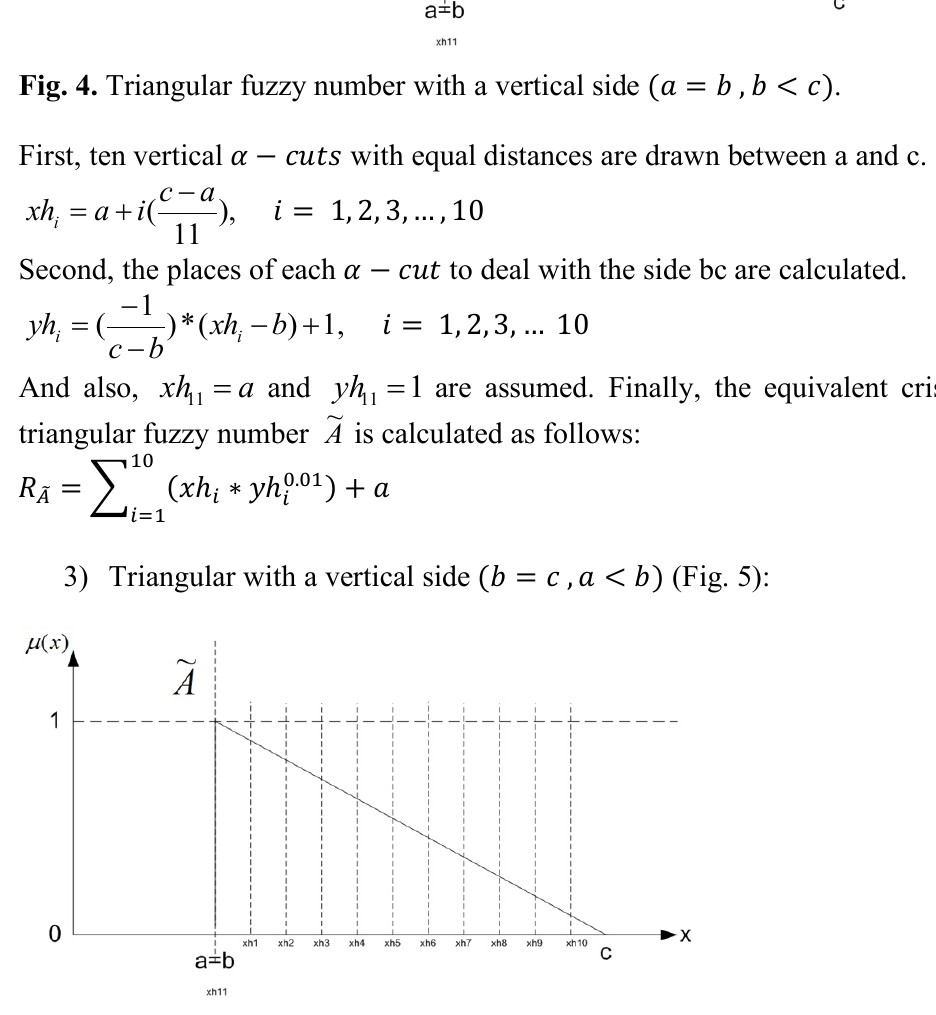
Fig. 5. Triangular with a vertical side (𝑏 = 𝑐 , 𝑎 < 𝑏)